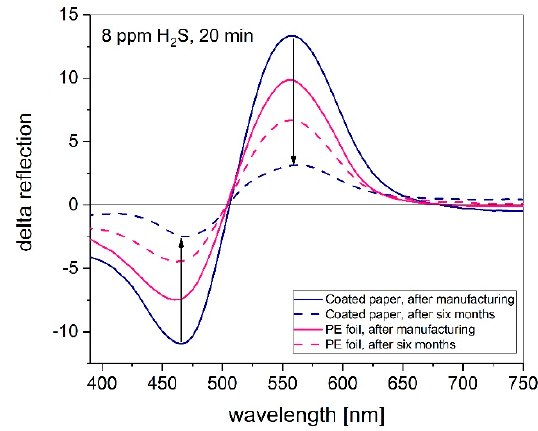
Figure 9. Delta reflection of Cu-PAN to 8 ppm H 2 S on coated paper and PE foil after manufacturing and after storage in ambient air at room temperature for 6 months.